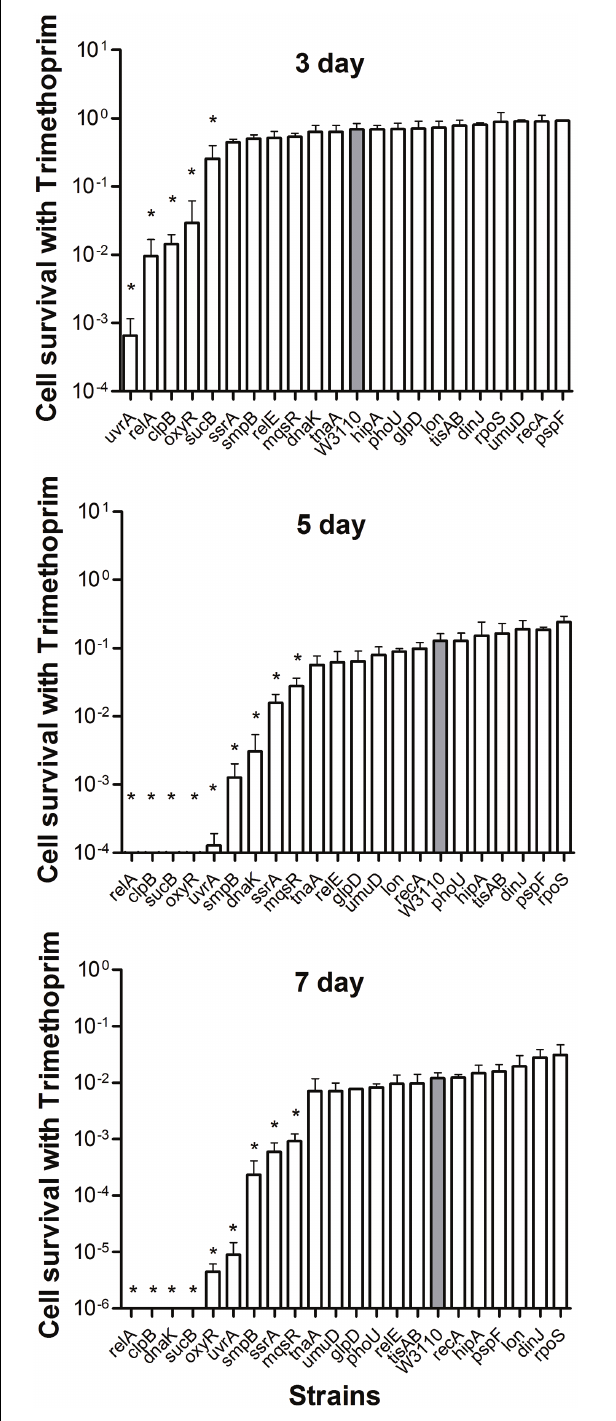
FIGURE 4 | Deletion mutant ranking depends on cell survival over time under conditions of trimtheprim exposure. Stationary phase cultures of W3110 and single-gene mutants were diluted 100-fold and exposed to 64 μ g/ml trimethoprim for 3, 5, and 7 days. The data for each mutant was plotted and compared with that of W3110. Error bars indicate the standard deviation ( n = 3). The asterisk indicates statistical significance as determined using Mann–Whitney U tests ( ∗ P <